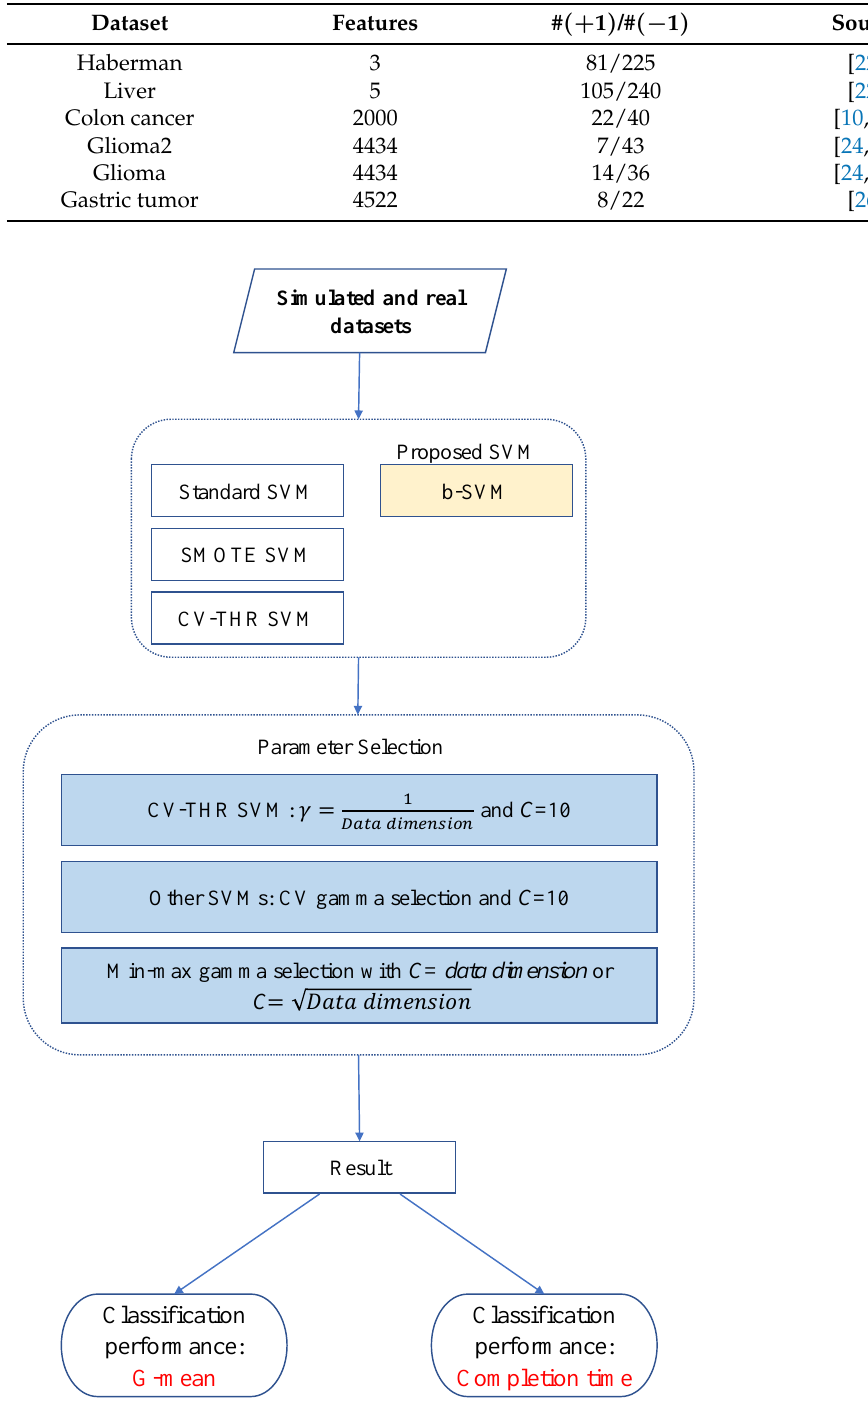
Table 1. Summary of real datasets used in the experiments.